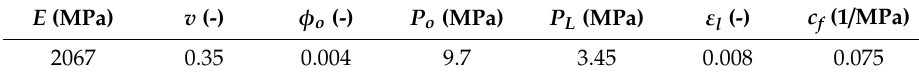
Table 5. Northeast of Fairway San Juan Basin